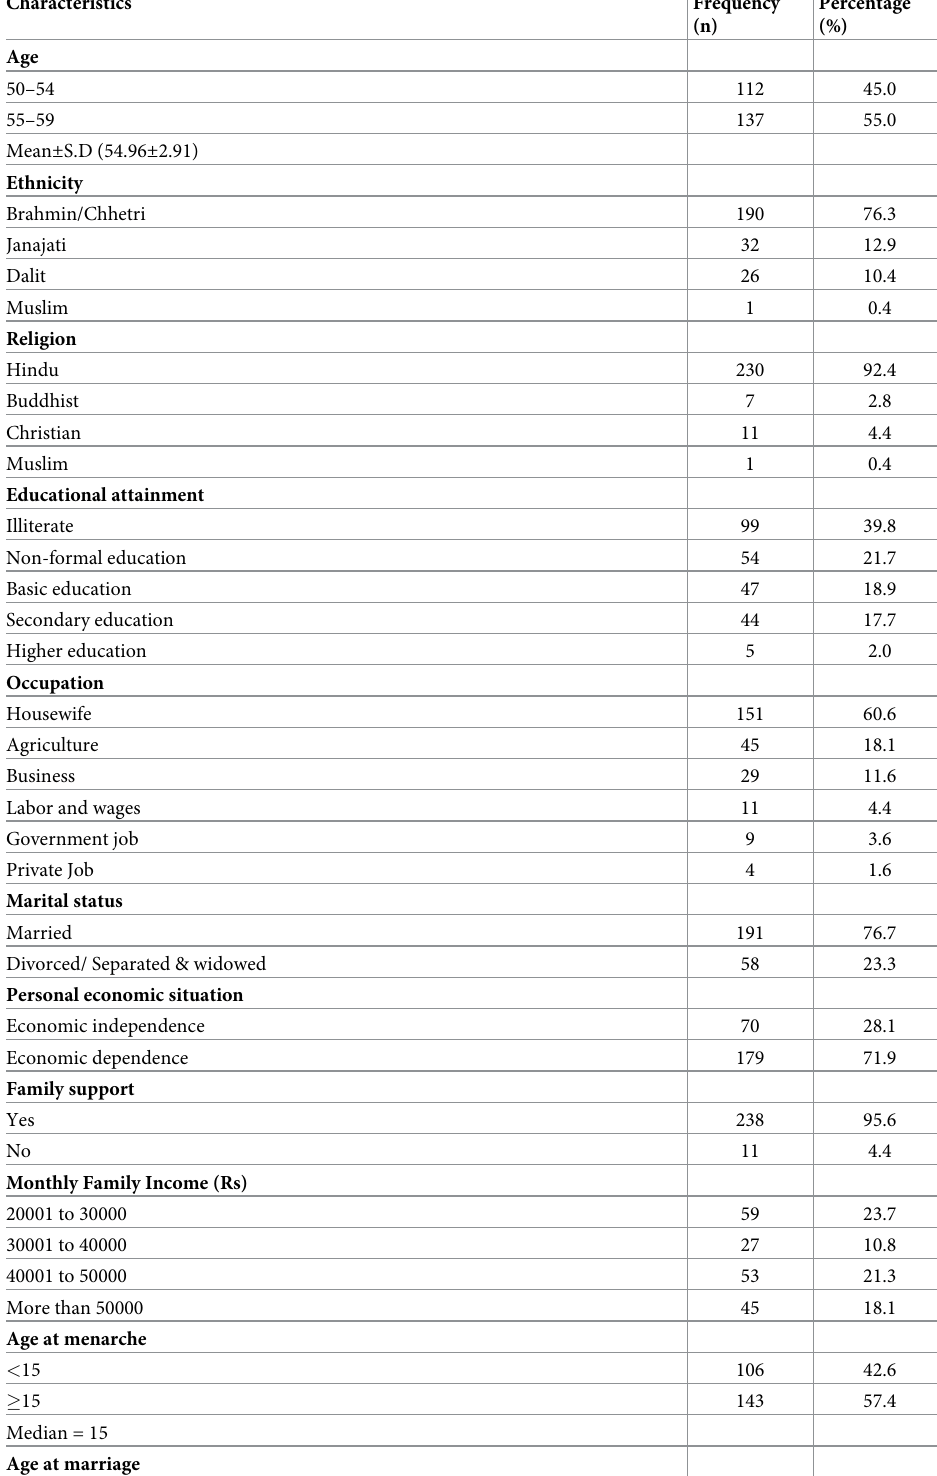
Table 1. Socio-demographic, obstetric, lifestyle-related characteristics and health problems of the participants (n = 249).